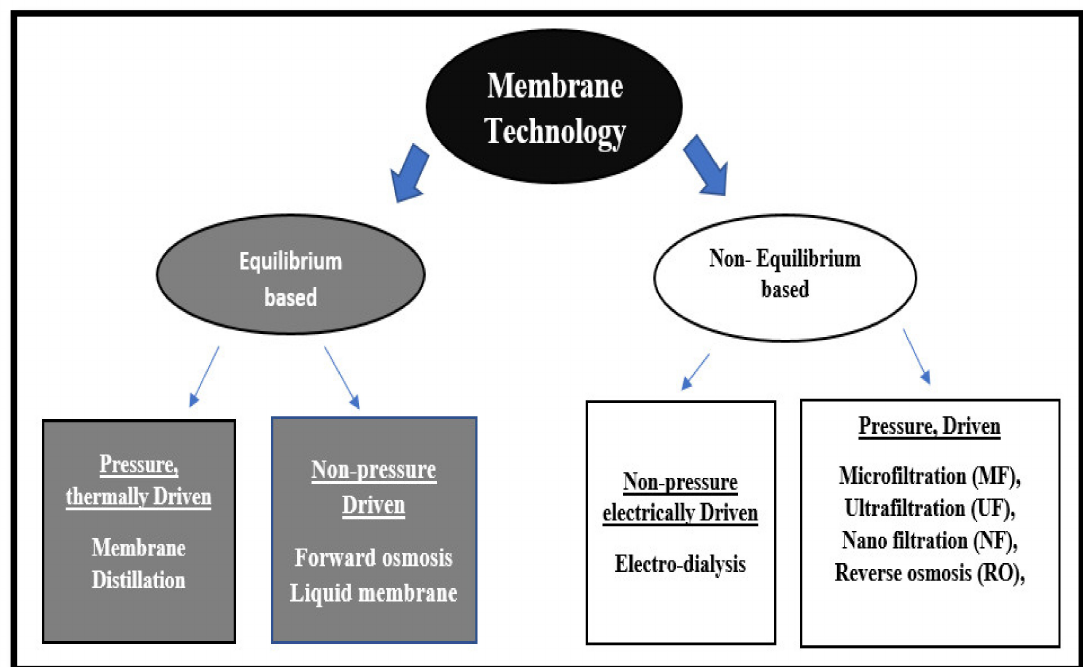
Figure 8. Some membrane processes are depicted schematically. Adapted from [91], with permission from